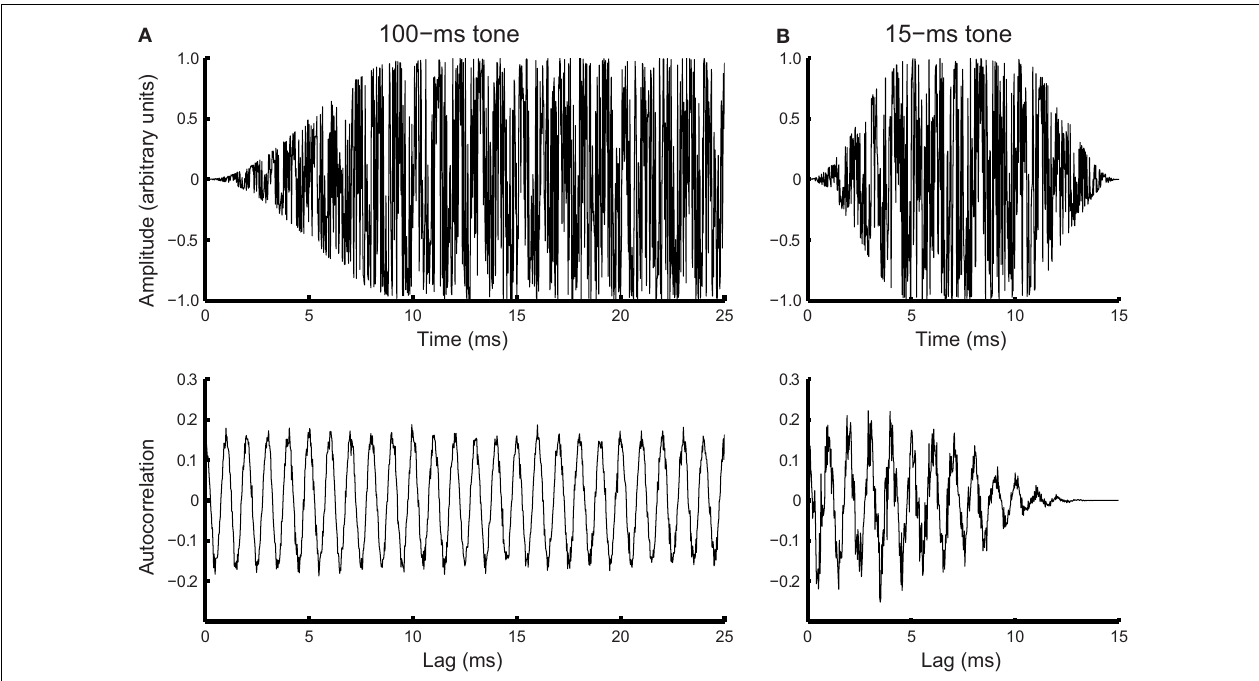
FIGURE 4 | Simulated phase locking noise. Simulated waveform (top) and corresponding autocorrelation function (bottom) for a (A) noisy 100-ms, 1-kHz tone (first 25ms of the signal shown), and (B) noisy 15-ms tone of the same frequency.